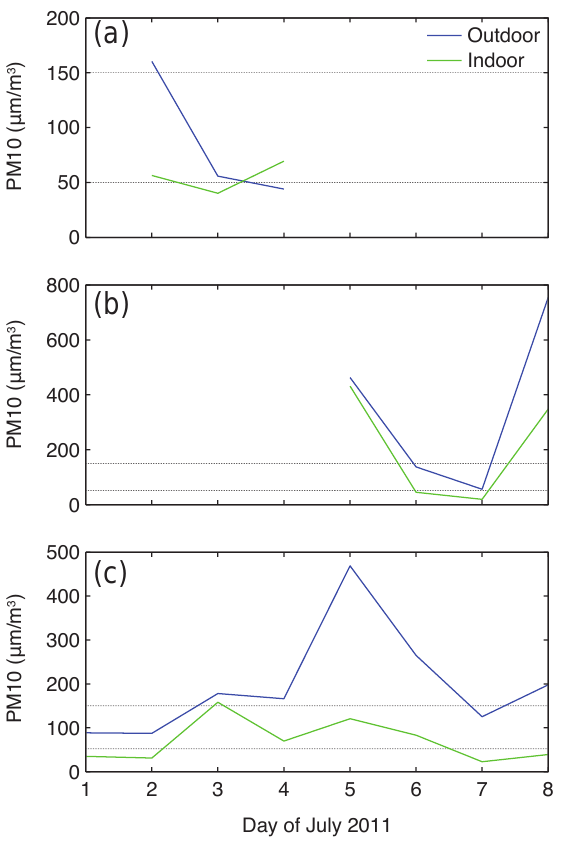
Figure 6. PM 10 concentration measured indoor and outdoor for Villa La Angostura and Ingeniero Jacobacci during the beginning of July 2011. (a) Villa La Angostura hospital; (b) Villa La Angostura CPEM 68 School; (c) Ingeniero Jacobacci School 356. The horizon- tal lines indicate maximum levels for a 24h exposure (150µgm − 3 ) and for an exposure of 1 year (50µgm − 3